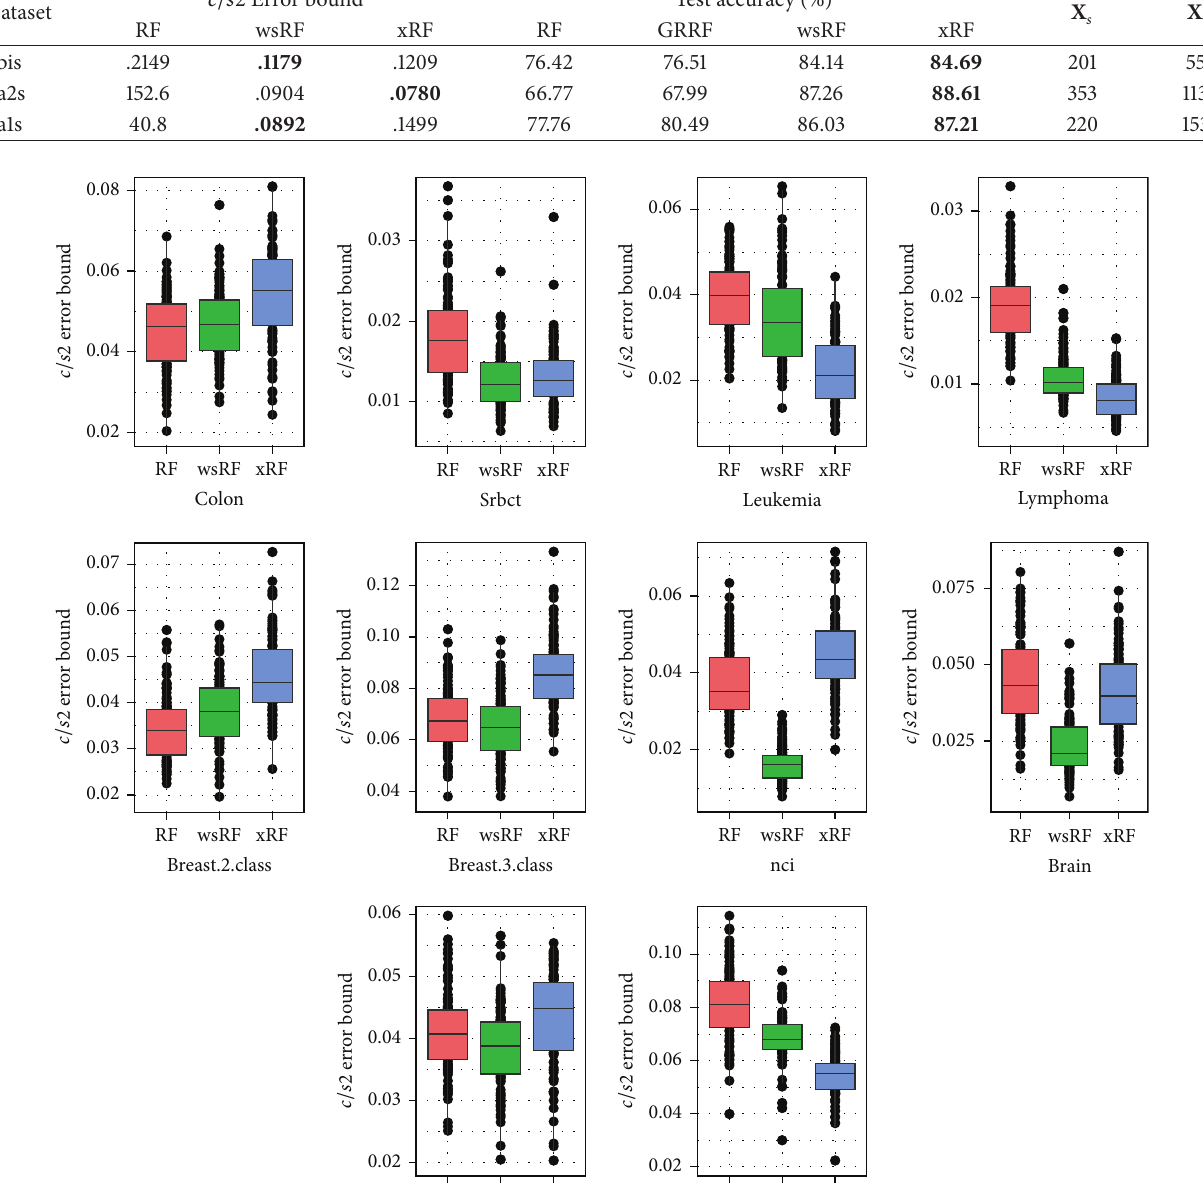
Table 6: The accuracy of prediction and error bound 𝑐/𝑠2 of the models using a small subspace 𝑚𝑡𝑟𝑦 = [ log 2 (𝑀)+1] ; better values are bold. Dataset